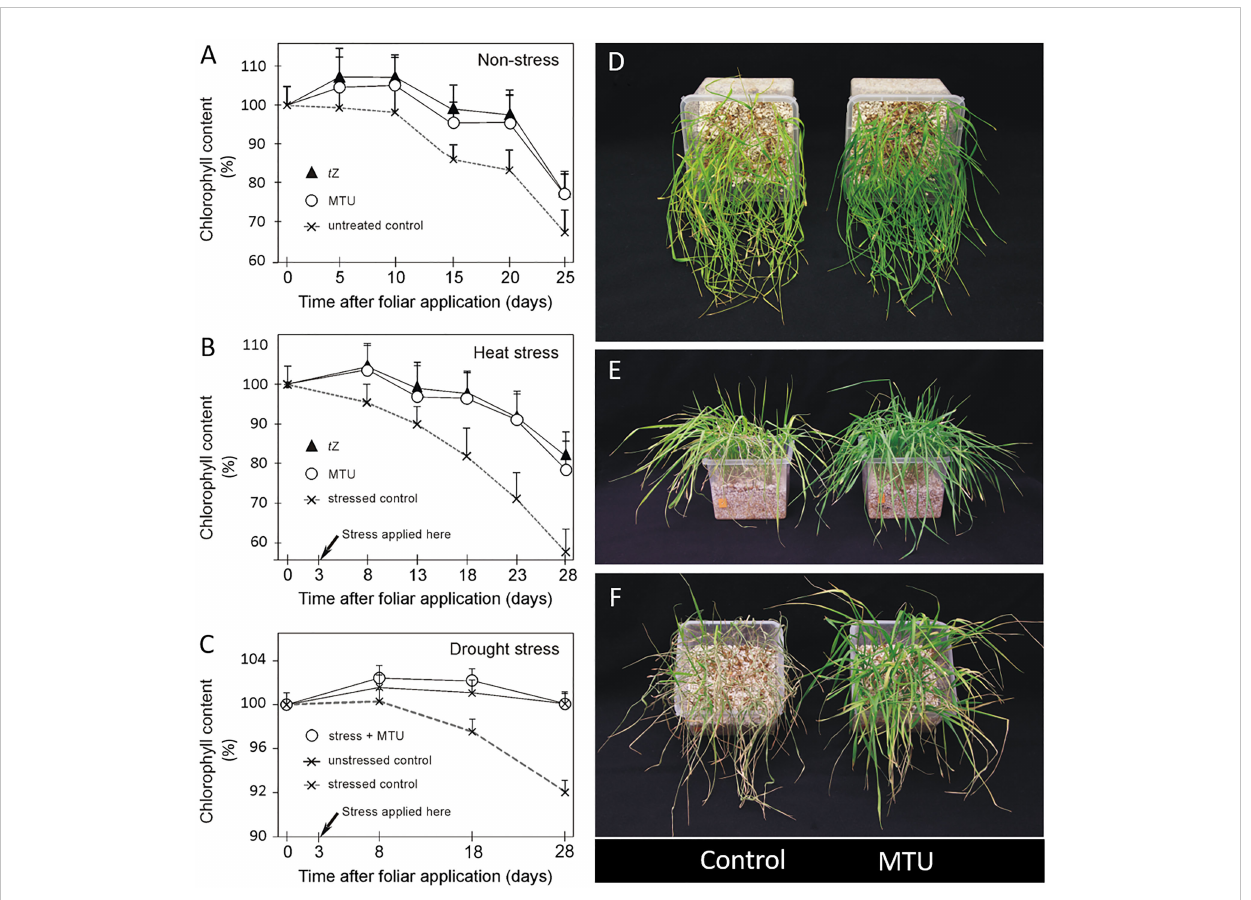
FIGURE 1 The effect of MTU (and t Z) on chlorophyll content in wheat. (A-C) The 20-day-old plants were treated with water (untreated control), 1-(2-methoxy-ethyl)- 3-1,2,3-thiadiazol-5-yl urea (MTU), or trans -zeatin ( t Z) and grown another 25/28 days under optimal conditions (A) , heat stress conditions (B) , and drought stress conditions (C) . Relative chlorophyll content was assessed on third leaves by SPAD meter. Values are means + SD of ten biological replicates and are expressed in % of chlorophyll content before application (day 0). Weight parameters of these plants (harvested 45 or 48 days after planting) are shown in Table 1. (D) 21-Day-old plants held for the last seven days without water. (E) The same 23-day-old plants held for 8 days without water and photographed 24 hours after re-watering. (F) 25-Day-old plants held for the last 10 days without water, photographed 24 hours after